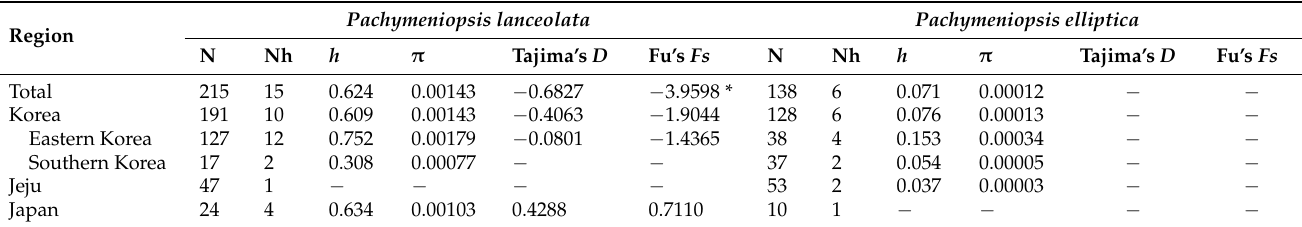
Table 1. Diversity measures and neutrality tests for populations of two Pachymeniopsis species based on rbc L sequences. Number of specimens (N), number of haplotype (Nh), haplotype diversity ( h ), and nucleotide diversity ( π ). Significant p -values indicated by * p <